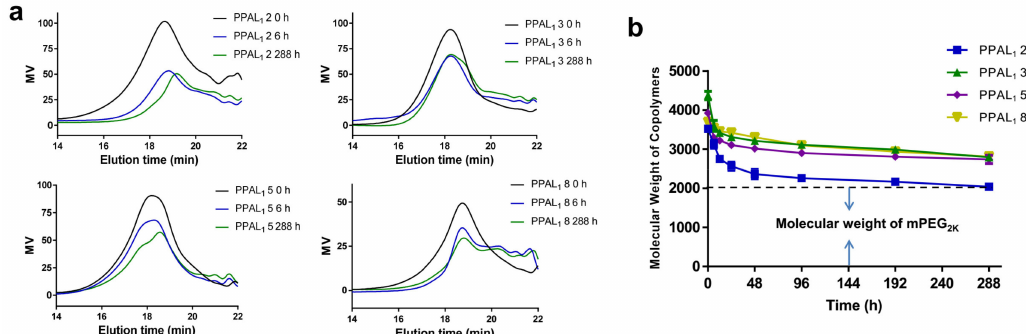
Figure 5. In vitro degradation of the functional copolymers. ( a ) GPC of PPAL 1 2 , PPAL 1 3 , PPAL 1 5 and PPAL 1 8 copolymers at 0 (trace black), 6 (trace blue) and 288 h (trace green) in pH 7.4 PBS at 37 ◦ C. ( b ) The time courses of the in vitro hydrolytic degradation of PPAL 1 2 , PPAL 1 3 , PPAL 1 5 and PPAL 1 8 copolymers during 288